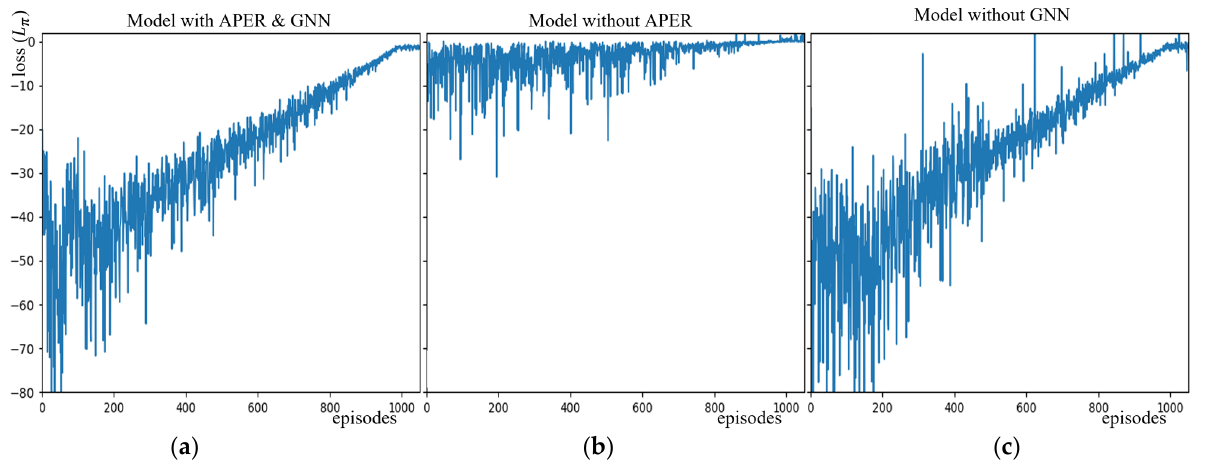
Figure 10. Convergence curves. ( a ) APER and GNN; ( b ) without APER; and ( c ) without GNN.